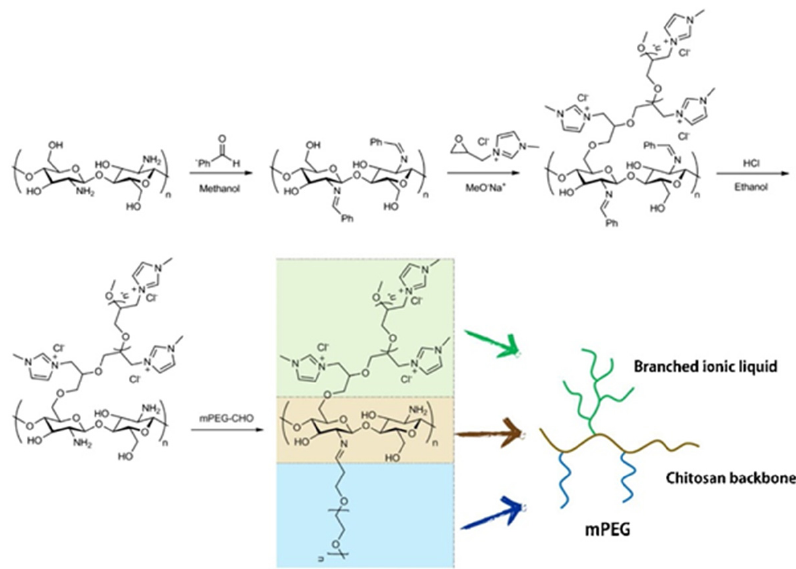
Scheme 1. Schematic representation of preparation of multi-branched IL-based chitosan grafted m-PEG to coat the surface of Fe 3 O 4 NPs for simultaneous delivery of Doxorubicin (DOX)